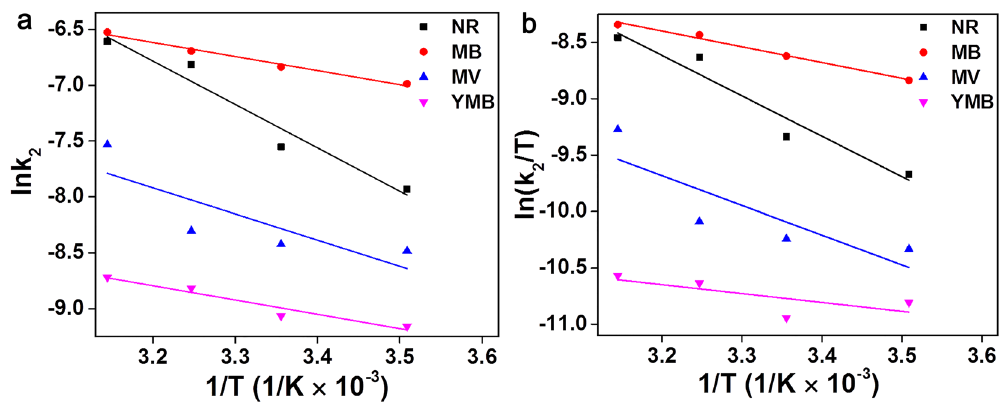
Figure 3. Plots of ( a ) Arrhenius and ( b ) Eyring for NR, MB, MV and YMB adsorption on the PAAM/PA/PDA hydrogel,